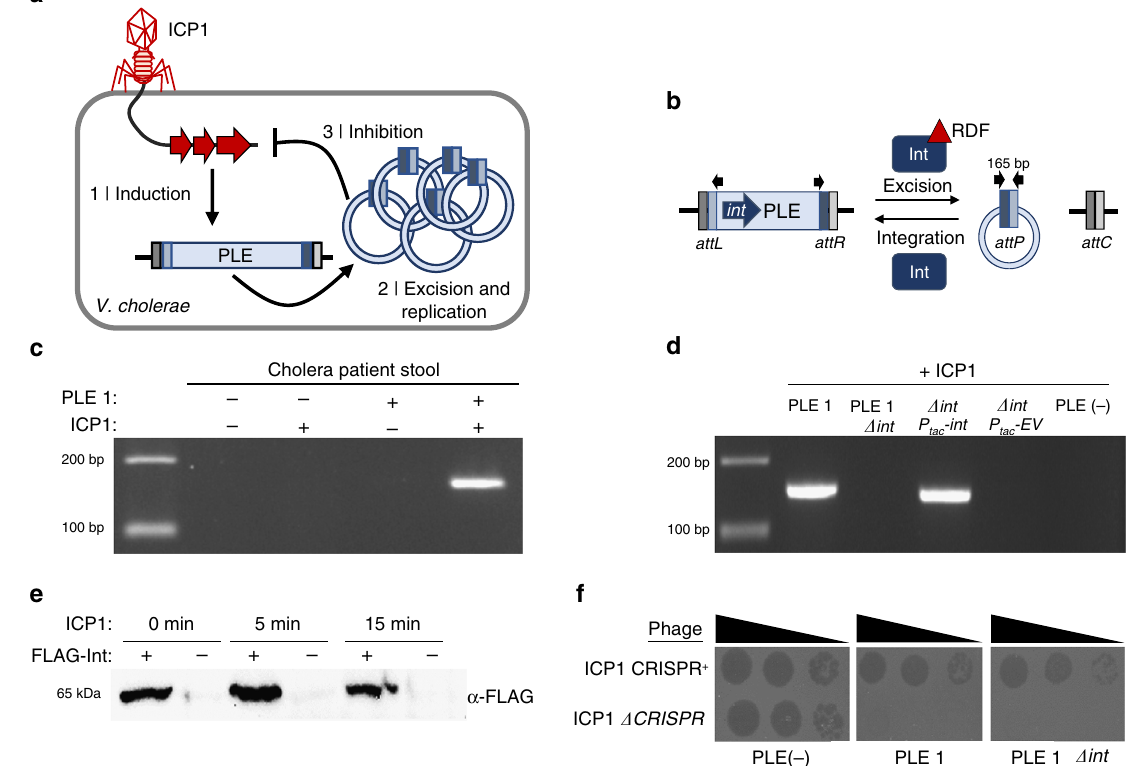
Fig. 1 PLE circularizes during ICP1 infection and this response is dependent on PLE-encoded Int. a ICP1 injects its DNA into a PLE + V. cholerae cell, leading to (1) PLE induction. (2) Induced PLE excises from the chromosome and circularizes, replicating to high copy number 20 . Through an unknown mechanism, (3) PLE inhibits the ICP1 replication program and protects the V. cholerae population from ICP1 predation. b Model of LSR/RDF mediated integration and excision of PLE and the resulting att sites. Black arrows indicate primers used to detect PLE circularization. c Circularized PLE, which is detected by PCR